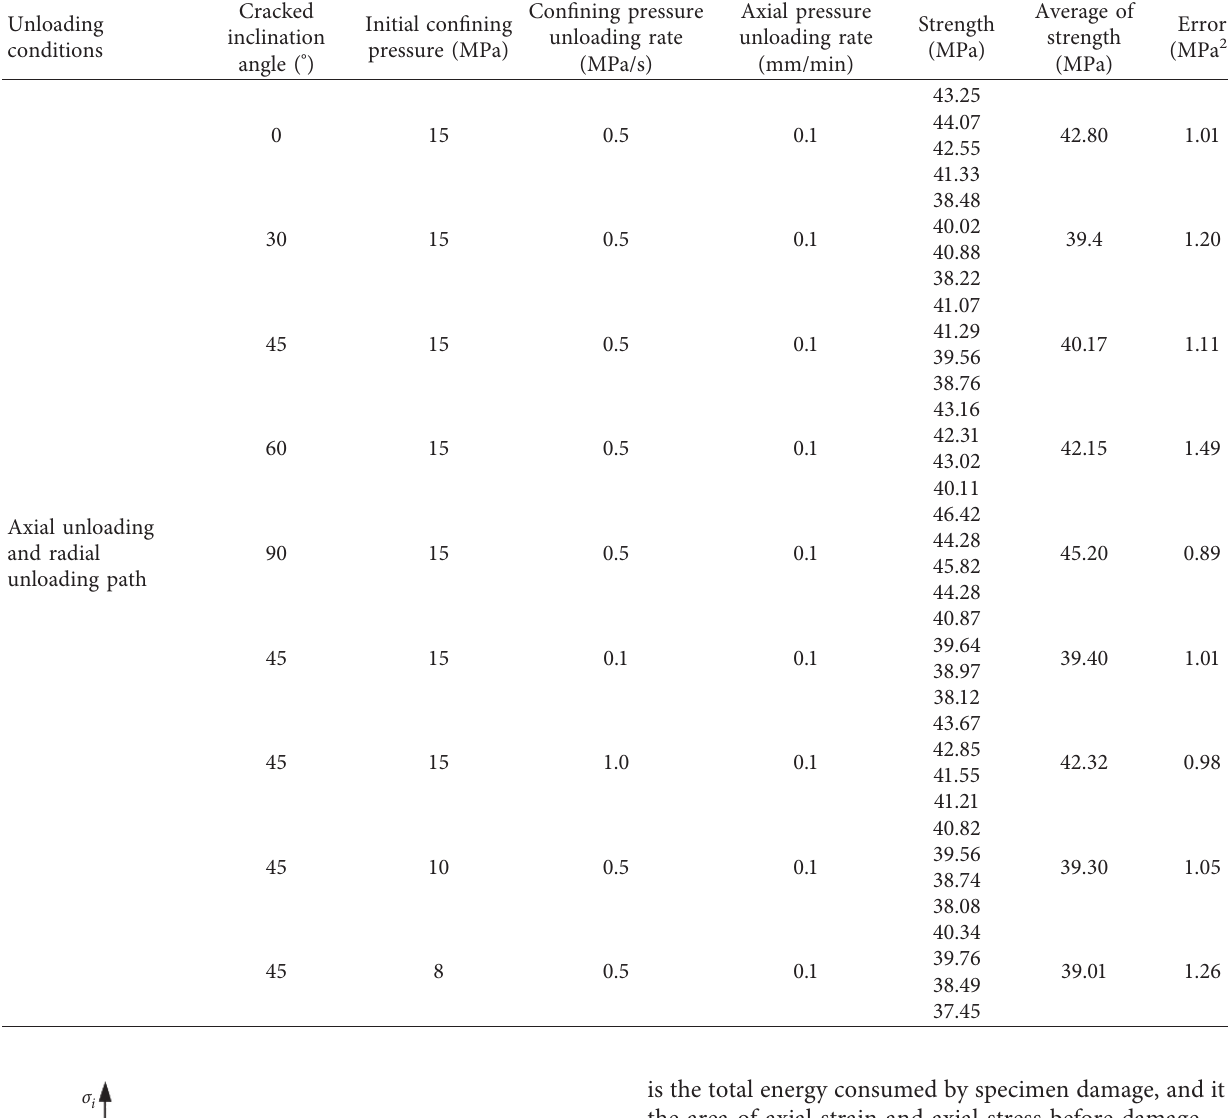
Table 2: Test results of cracked specimens under different axial unloading and radial unloading paths.